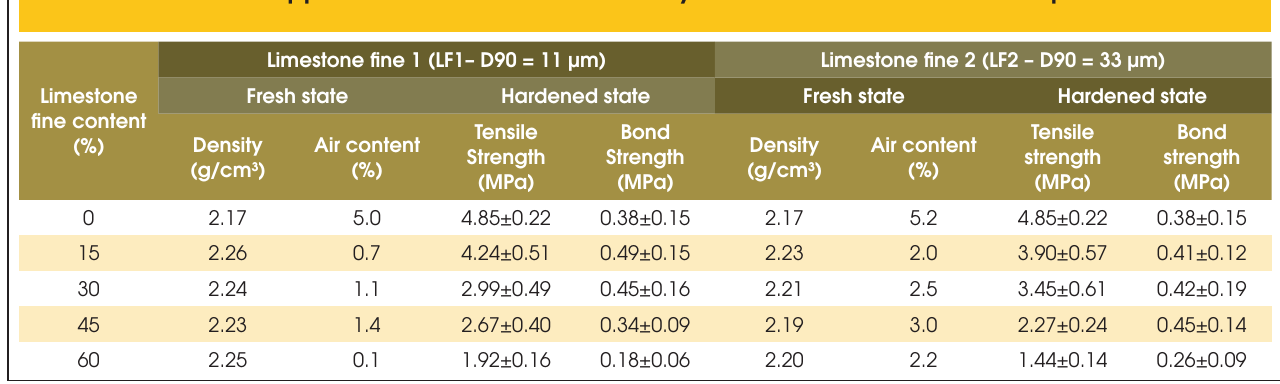
Table 5 – Characterization of mortars studied in fresh and hardened state and the results of bond strength at 14 days for mortars with 0%; 15%; 30%; 45% e 60% of the